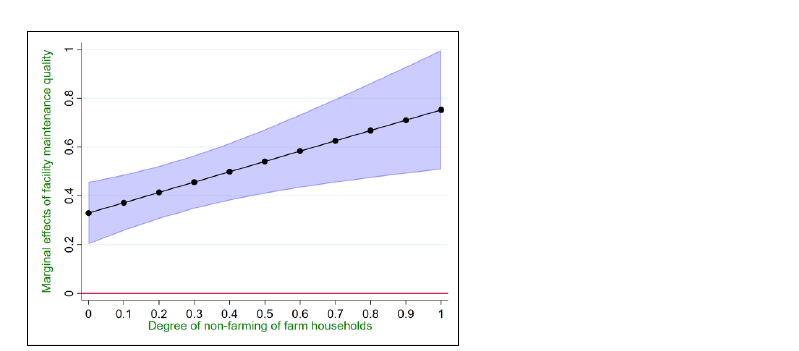
17 of 25 Figure 5. Moderating effect of the degree of non-farming of farm households on the quality of facility maintenance.Note: The black line in the figure indicates the moderating effect of the degree of non-farming of farm households on the quality of facility maintenance affected by property rights reform. The blue area represents the 95% confidence interval. The red line in the figure represents the significance level. 2. Moderating effects of the degree of non-farming on farmers ’ water-saving technology adoption behavior Model 2 in Table 7 shows the regression results after adding the moderating variable “ degree of non-farming of farm households ” to the baseline model. The results show that the degree of non-farming of farm households has a positive moderating effect on the property rights reform affecting the adoption behavior of farm households for water- saving technologies. According to the calculation, the specific moderating effect is shown in Figure 6. The figure shows that the marginal effect of property rights reform on farmers ’ water-saving technology adoption behavior in the reformed areas increases with the